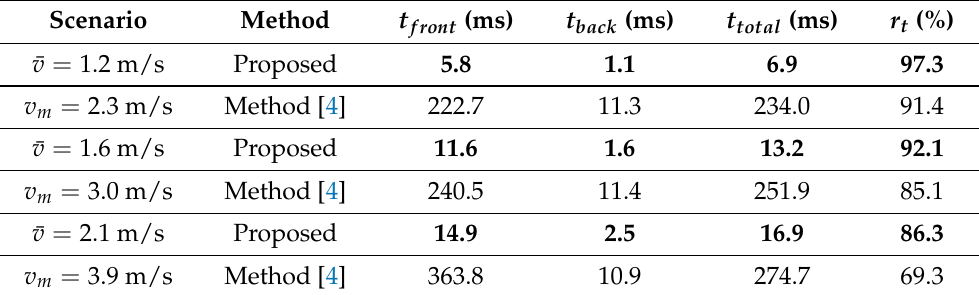
Table 1. Tracking trajectory planner comparison in multiple complex